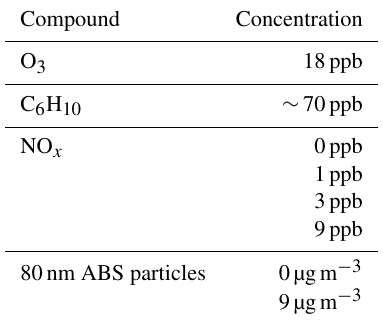
Table A1. The approximate reactant, oxidant and particle concen- trations during the conducted experiments. Cyclohexene concentra- tion is a very rough estimate based on changes in ozone concentra- tion.